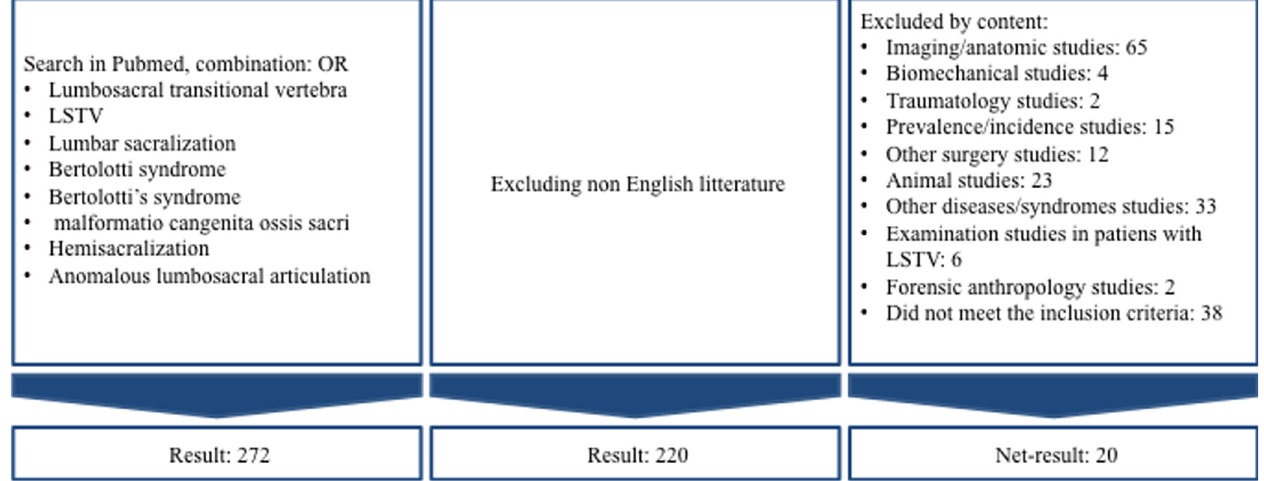
Figure 1. Inclusion fl